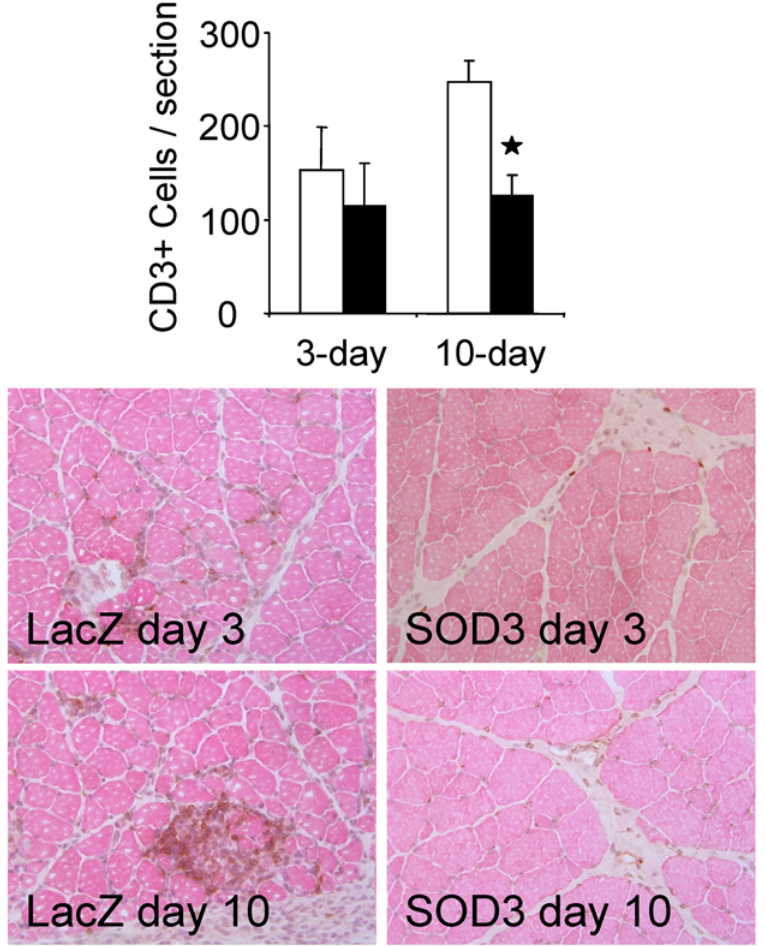
Figure 2. Inhibition of T-cell migration. Open bars represent LacZ animals and black bars represent SOD3 animals. Infiltration of CD3 + lymphocytes was inhibited in SOD3 animals 10 days after injury remaining at the level seen at earlier 3-day time point (20 6 magnification).